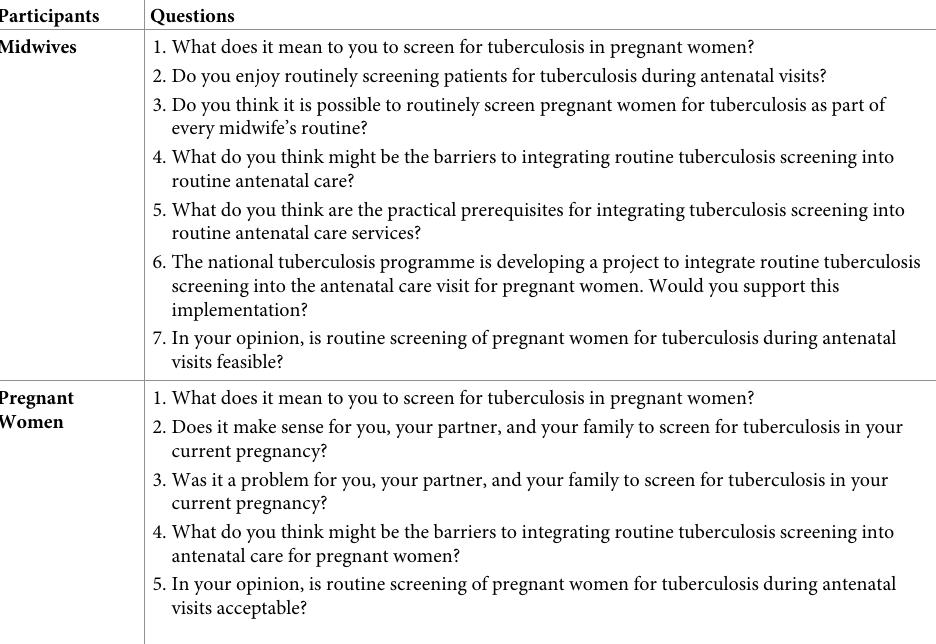
Table 1. Questions from in-depth interviews with midwives and pregnant